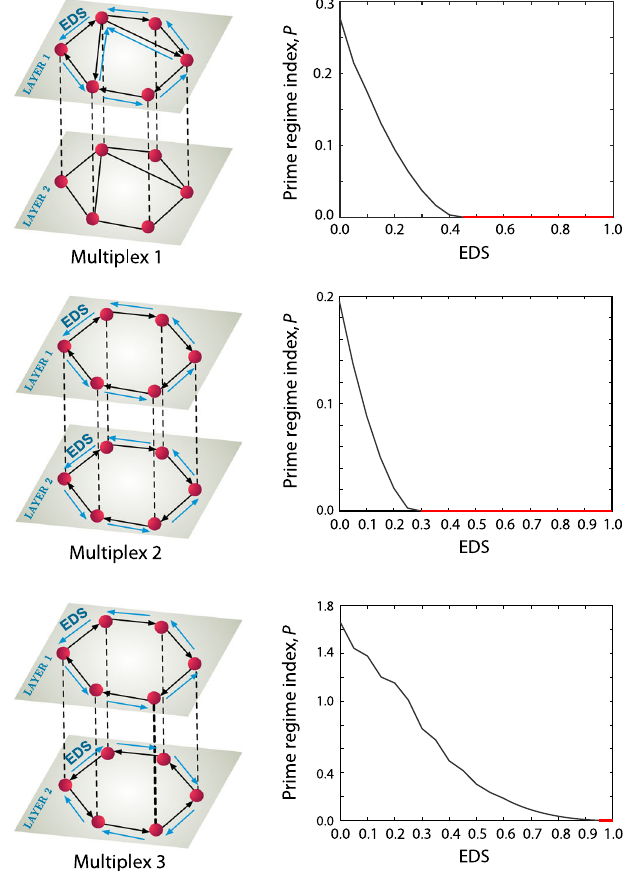
FIG. 12. The prime regime index P is explored for the three multiplexes as a function of the directionality of their layers, which is controlled by the EDS [ P ¼ 0 (red line) indicates that the prime regime is not exhibited]. The complementariness of the topologies of the constitutive layers of the multiplex is an important constraint setting the threshold in the EDS for which the prime regime is